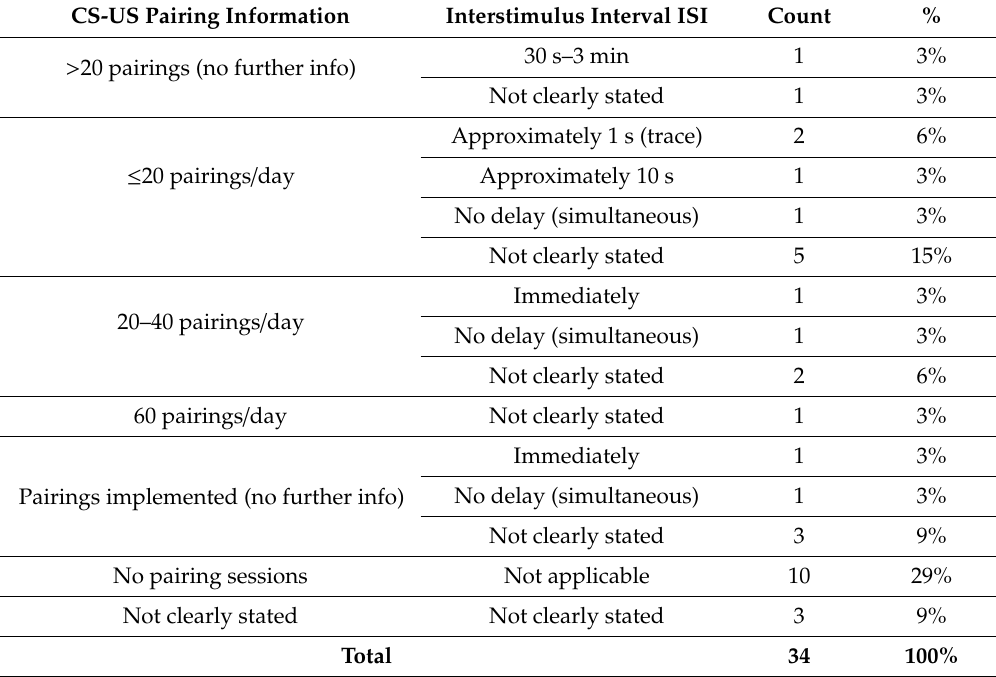
Note: Percentages may not total 100% due to rounding. Table 6. Approximations of the delays between the display of the target responses (R; e.g., nose touch) and the onset of the conditioned reinforcer (S r + ; e.g., click or spoken word) reported across all eligible studies. Beep Buzzing Sound Clicker Spoken Word Whistle Total Delay R → S r + Count